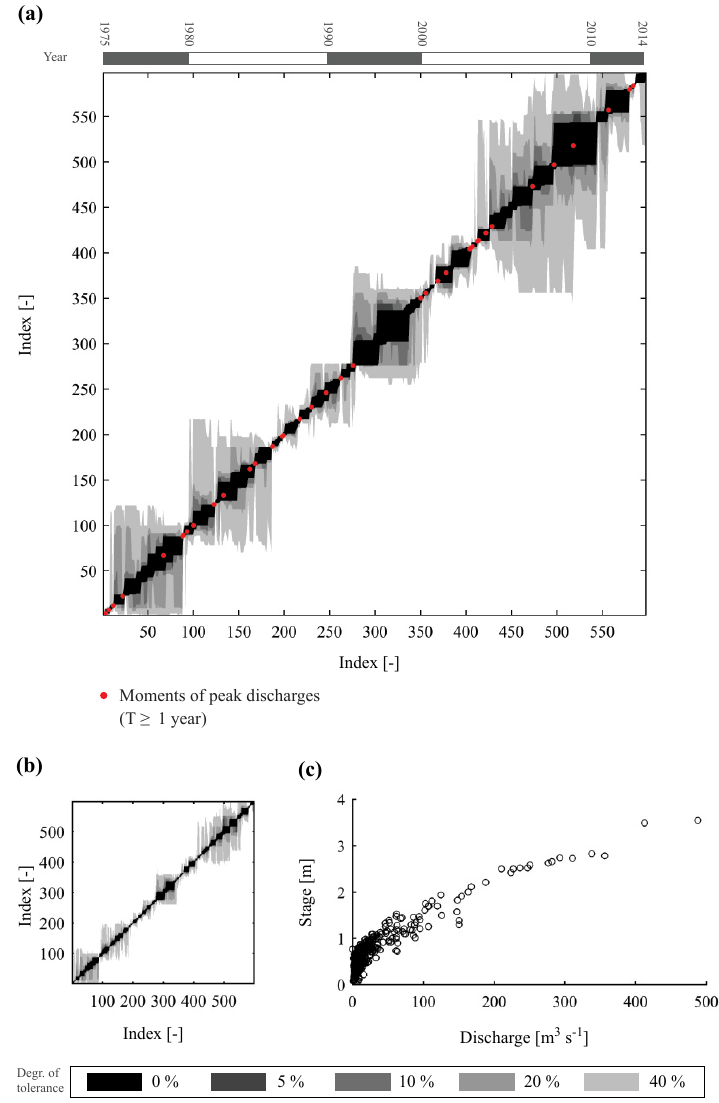
Figure 6. Combined BReach t_2s plot (all data) for Mais using uncertainty boundaries from (a) McMillan et al. (2010) and (b) Coxon et al. (2015). In all subplots, for each index on the x axis the gray area indicates the span between the index of the maximum left reach (under the bisector) and the maximum right reach (above the bisector). Each gray tint represents a different degree of tolerance (i.e., percentage of data points allowed to have nonacceptable model results). (c) Stage–discharge data for